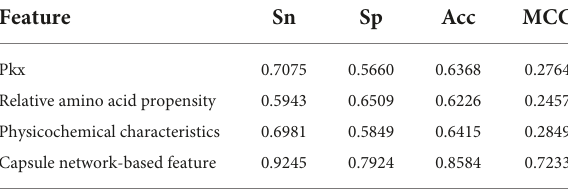
TABLE 5 Performance comparison across different features by logistic regression.